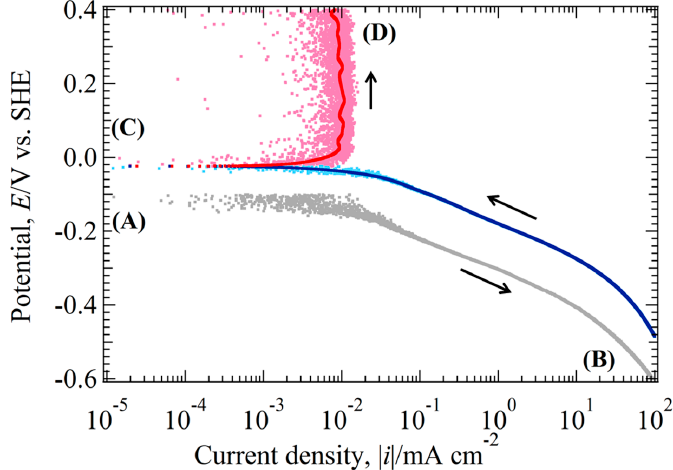
Figure 1. Experimental polarization curve for Ag electrode in a moderately stirred 0.5 mol dm − 3 H 2 SO 4 solution saturated with H 2 gas bubbling at about 298 K. The (A) is a starting point and (D) is a finishing point for polarization, via point (B) and (C).